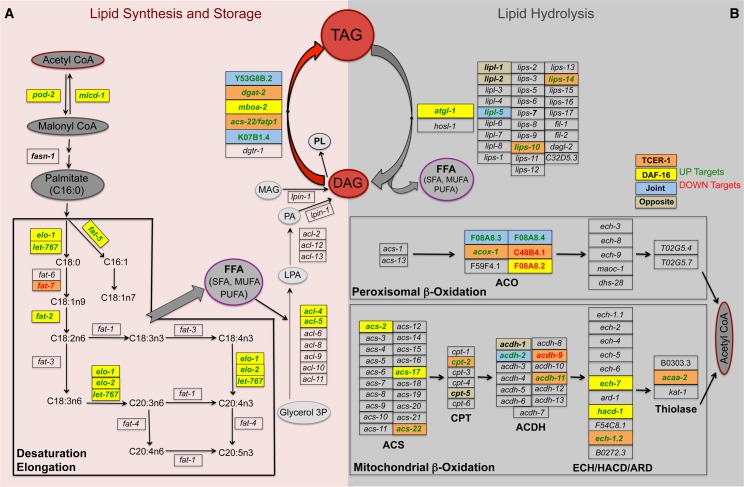
Key genes involved in lipid anabolism and catabolism are up regulated by DAF-16 and TCER-1 following germline loss.A. Lipid Synthesis: Overview of reactions involved in fatty-acid synthesis initiation, desaturation and elongation, and the steps leading up to triglyceride (TAG) formation. Acetyl CoA molecules, through the combined activities of the enzymes encoded by pod-2, mlcd-1 and fasn-1 are converted to the saturated fatty-acid (SFA) Palmitate (C16:0). Palmitate can be converted to longer mono- and poly-unsaturated fatty acids (MUFAs and PUFAs, respectively) by elongase and desaturase enzymes (encoded by ‘elo’ and ‘fat’ genes, respectively). These free fatty acids (FFAs) are joined with glycerol 3-phosphate (Glycerol 3P) to form lysophosphatidic acid (LPA) and phosphatidic acid (PA). PA and monoglycerides (MAG) serve as substrates for formation of diglycerides (DAG). DAGs are converted to the neutral, storage lipid TAGs by action of diacylglycerol acyl transferase (DGAT) enzymes. DAGs are also used in phospholipid (PL) production. B. Lipid Breakdown: Lipid degradation commences with the hydrolysis of TAGs into DAGs through the activity of ATGL-1, and other lipases and lipase-like enzymes (encoded by the ‘lipl’ and ‘lips’ genes). The FFAs released as a result are broken down to Acetyl CoA through peroxisomal- and mitochondrial- β-oxidation. Genes predicted to encode enzymes involved at different steps of these pathways are shown. ACO: acetyl CoA oxidase; ACS: acetyl CoA synthase; ACDH: acetyl CoA dehydrogenase; ECH: enoyl CoA hydratase; HACD: hydroxy acyl CoA dehydrogenase. Genes that were identified in the RNA-Seq analysis as DAF-16 and/or TCER-1 targets are highlighted in colored boxes as follows: DAF-16-Specific (yellow), TCER-1-Specific (orange) and Joint (blue). Genes up regulated by these proteins (UP) are written in green, whereas, DOWN targets are represented in red. Genes that were predicted to undergo opposite regulation by DAF-16 and TCER-1 are shown in olive boxes. Notably, pod-2, mlcd-1 and 4/6 genes encoding DGAT enzymes were identified as UP targets. K07B1.4 was not picked up by RNA-Seq but is highlighted because it was previously identified as a common target of DAF-16 and TCER-1 [24].